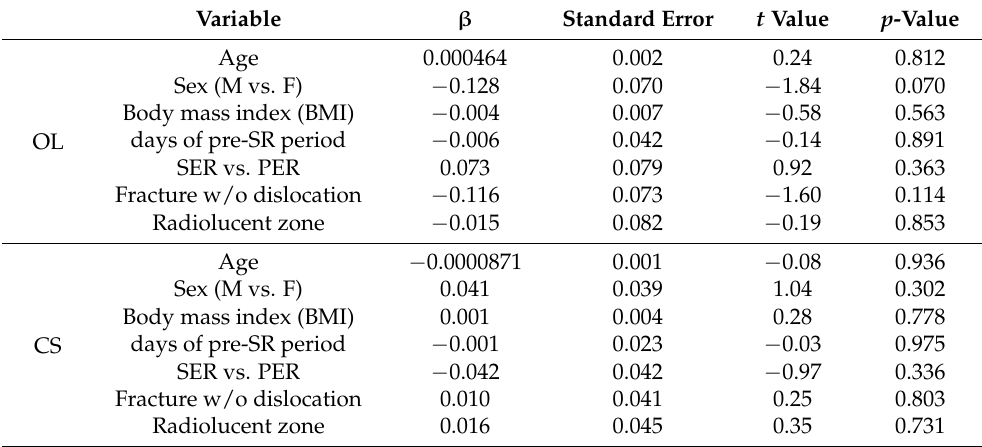
Table 5. Analysis of possible factors related to syndesmosis widening in the pre-SR